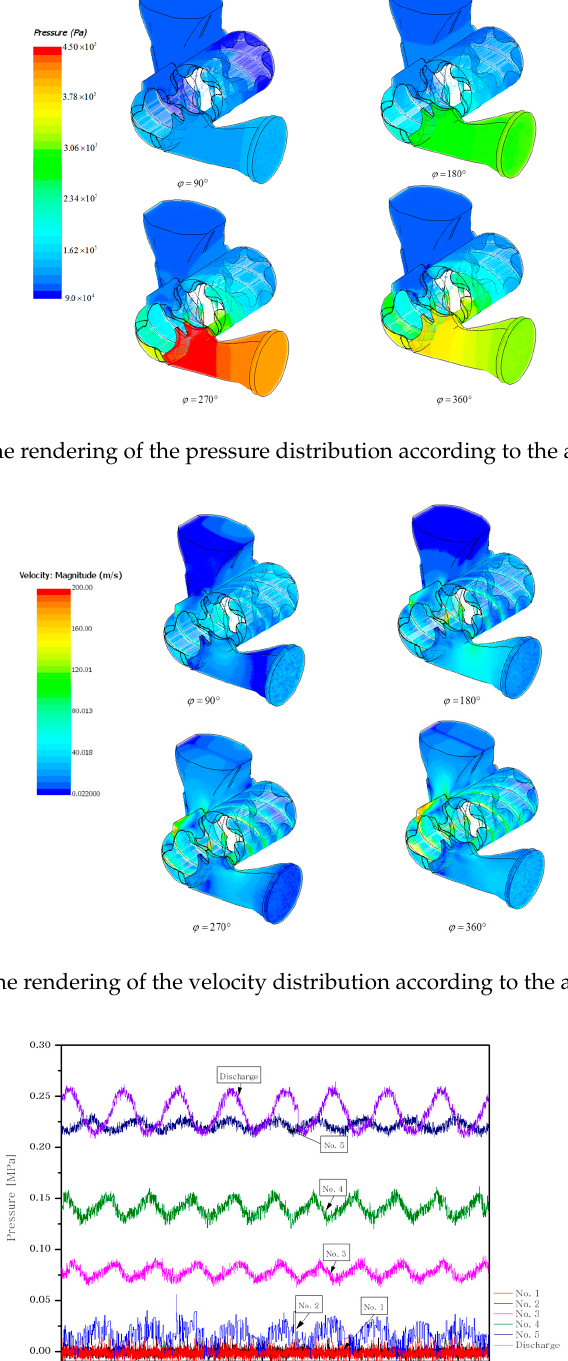
Figure 14. The periodical pressure signals versus male rotor rotation angle.